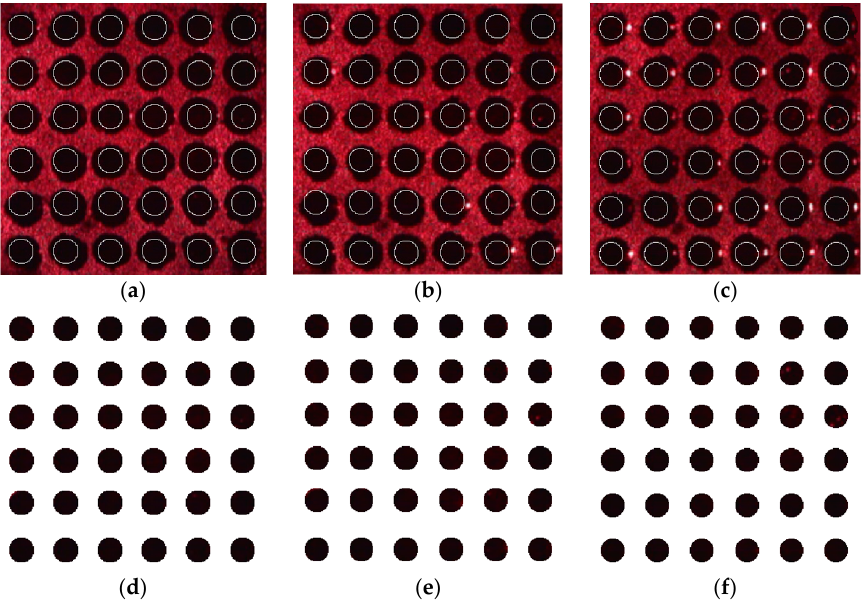
Table 3. Segmentation time.